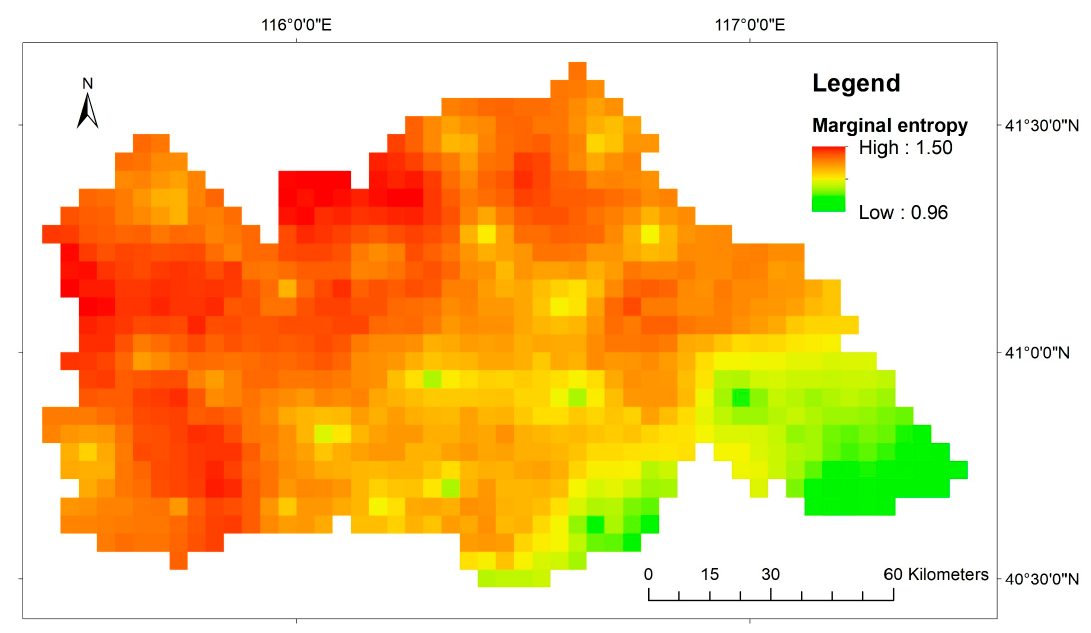
Figure 6. Spatial statistics of marginal entropy.